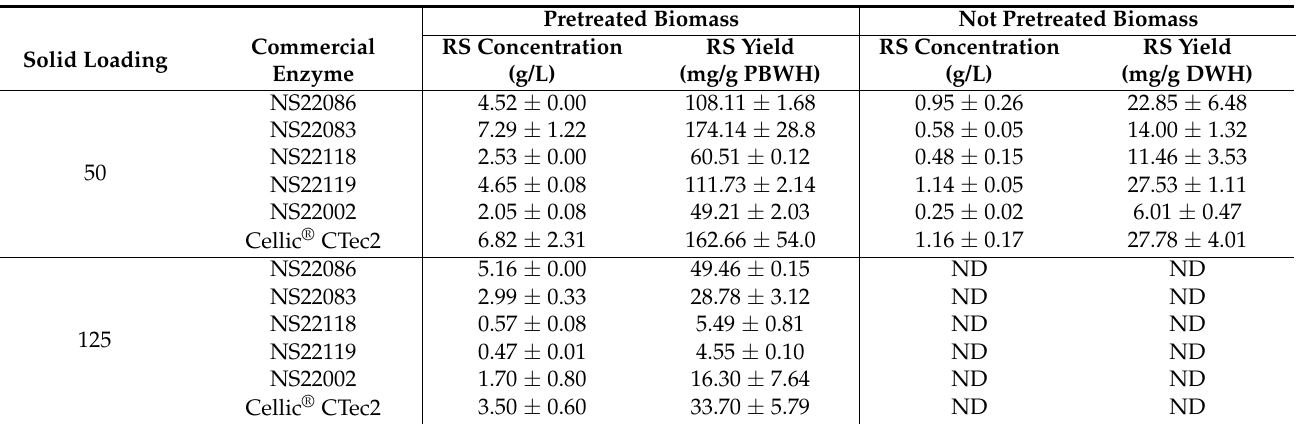
Table 4. Enzymatic hydrolysis of pretreated and not pretreated biomass of water hyacinth (at two solid loadings) by diluted (1:100) commercial enzymes. Pretreated Biomass Not Pretreated